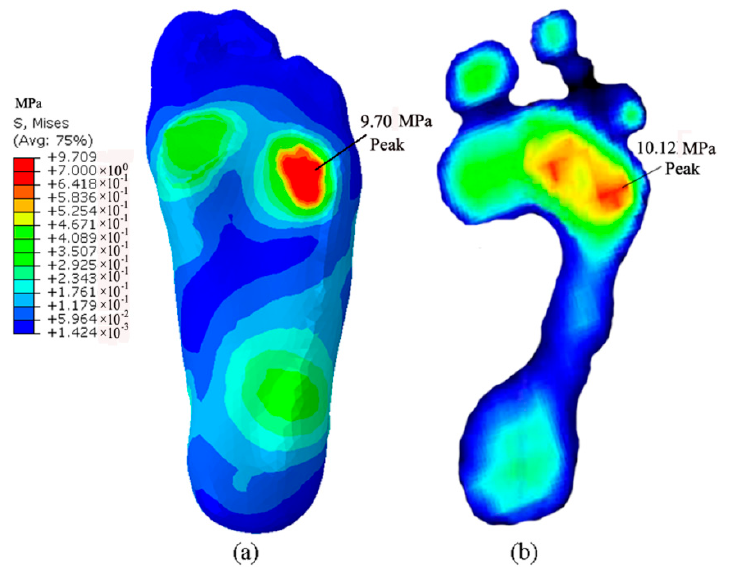
Figure 4. The plantar pressure standing on 20° incline: ( a ) FE model prediction; ( b ) F-scan meas-